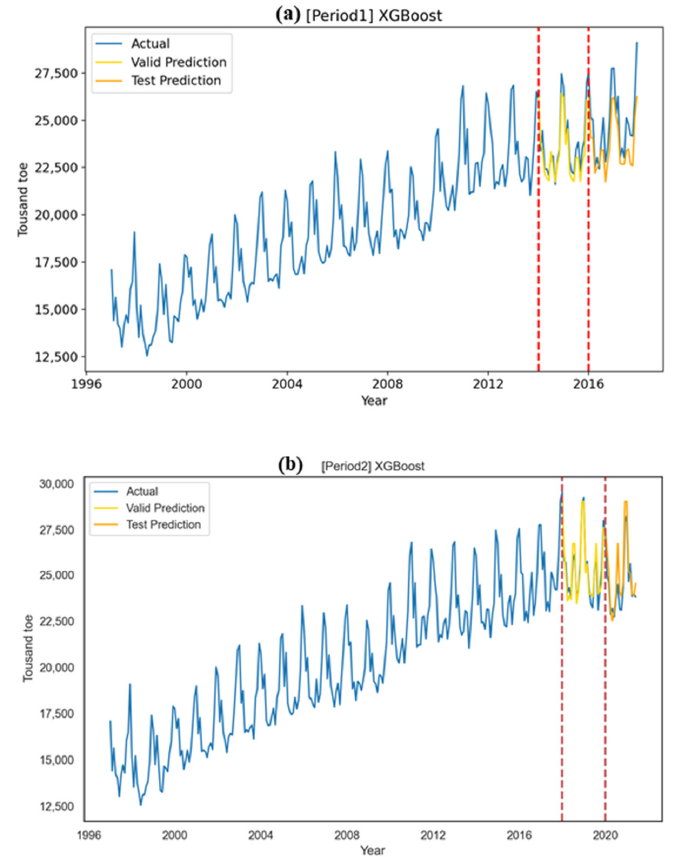
Figure 7. XGBoost